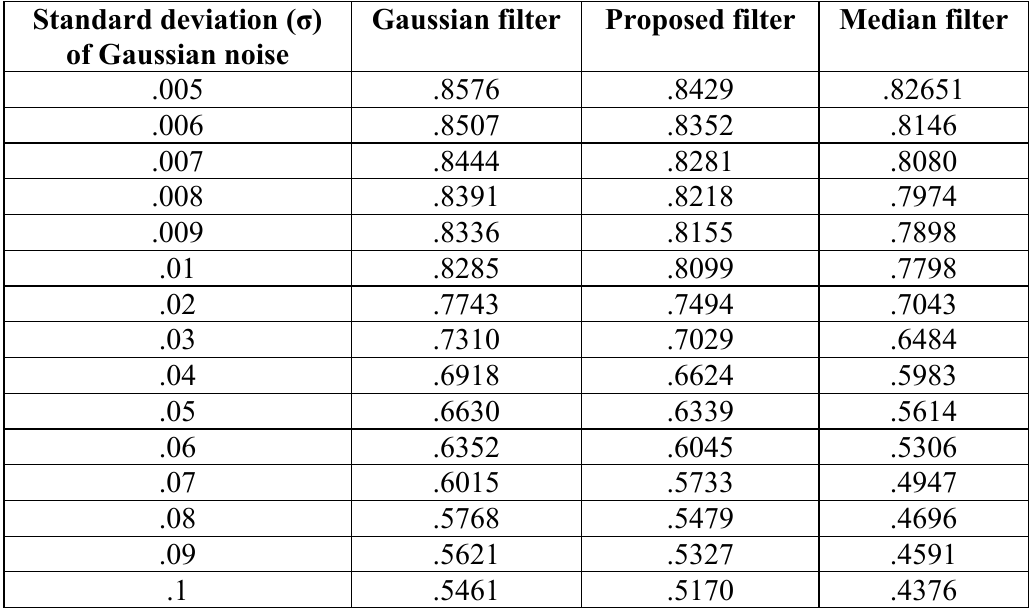
Table 2:The results of calculating ccc.